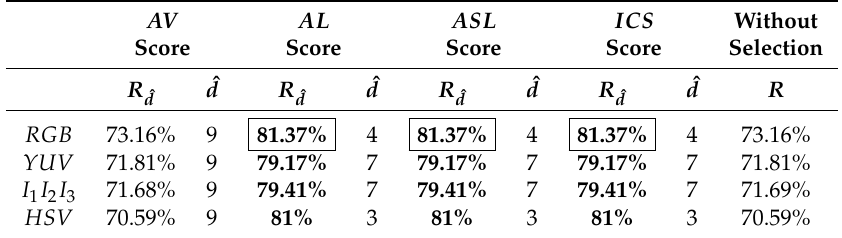
Table 4. Accuracy R ˆ (%) reached with the ˆ d -dimensional selected LBP histogram subspace, according d to the different supervised and unsupervised scores on the NewBarkTex set (the dimension of the histogram space is D × Q = 9 × 256 without